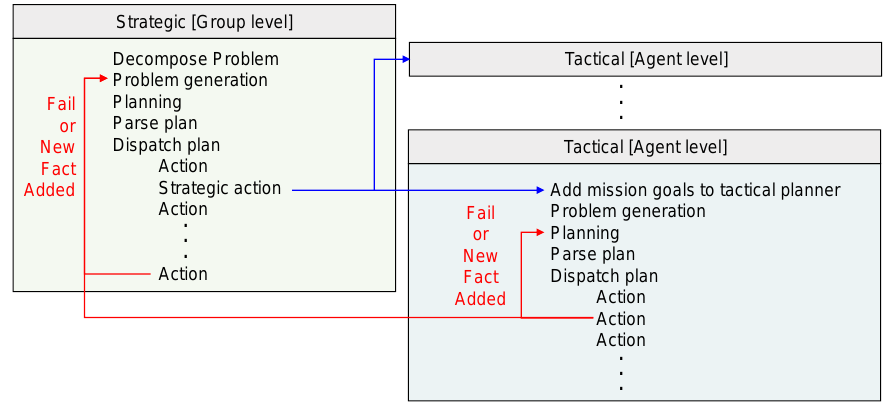
Figure 3. The flow of strategic and tactical planning: A plan is generated by dividing it into strategic and tactical levels for the task planning of a multi-agent system in a large area. At the strategic level, the plan is generated at the level of groups constituting the multi-agent system. At the tactical level, the sequence of actions of agents constituting each group is